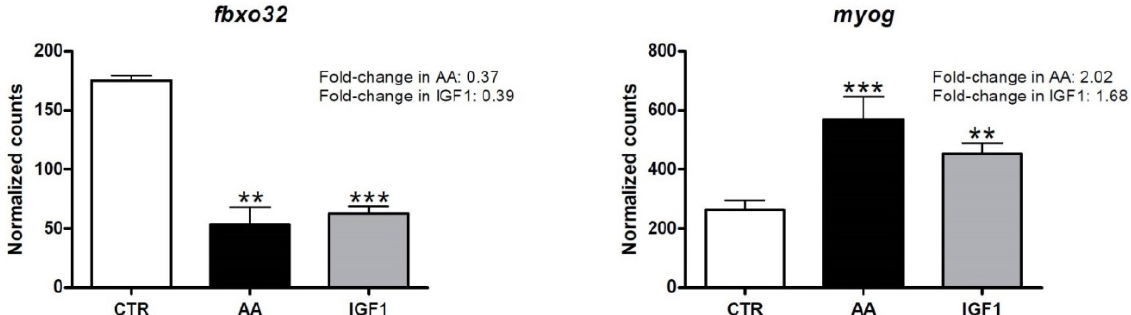
Figure 1. Digital expression of fbxo32 and myog . Gene expression of fbxo32 ( f-box protein 32 ) and myog ( myogenin ) in CTR, AA and IGF1 groups according to the differential expression analyses. Expression is shown as number of counts, and values represent means ± s.e.m. ( n = 3 independent cell cultures). The fold-changes are shown in the graphs and asterisks indicate significant differences compared to CTR: **: p -adj < 0.01; ***: p -adj < 0.001.